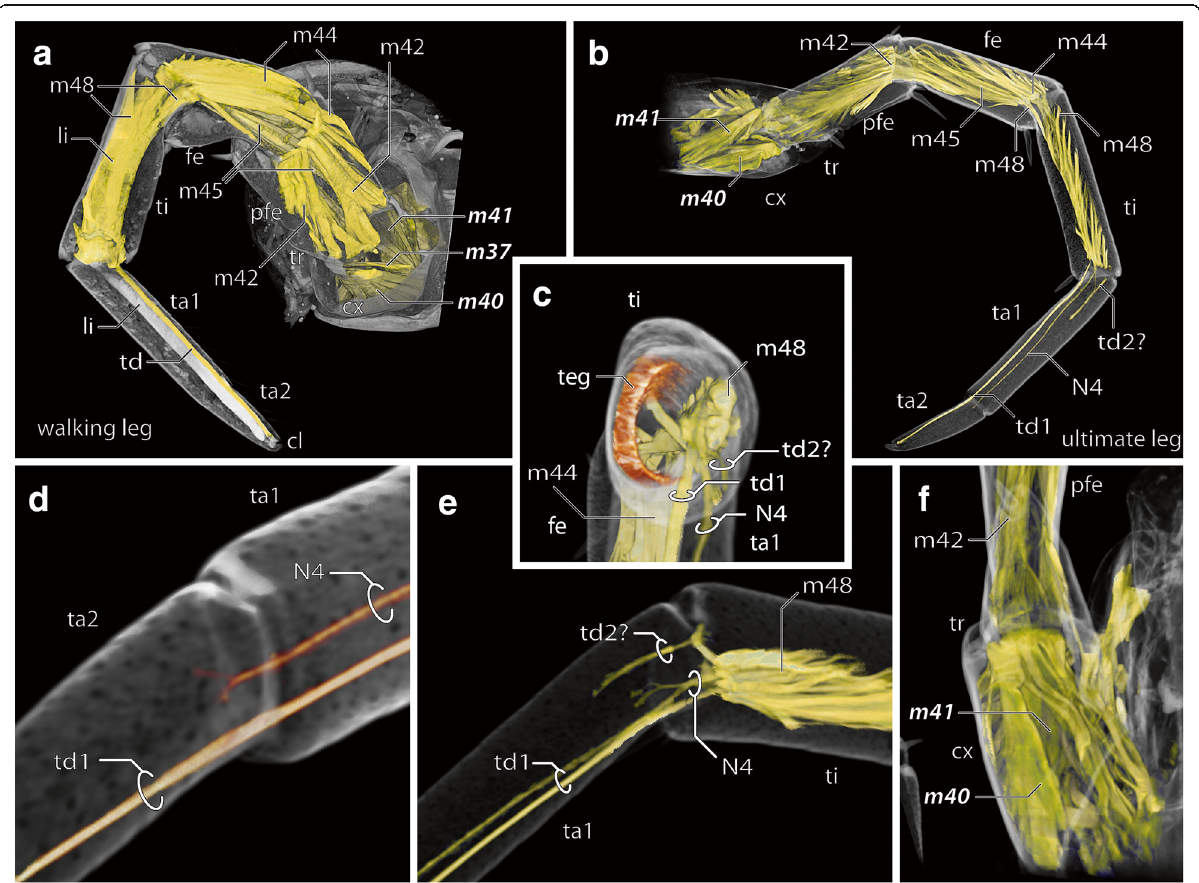
Fig. 4 Anatomy of walking leg 10 and ultimate leg. a 3D volume rendering of walking leg 10 and musculature, microCT analysis. Note that muscles labeled in bold either exhibit differences to ultimate leg muscles (m40 and m41, compare b ) or are absent in the ultimate leg (m37). b 3D volume rendering of ultimate leg and musculature, microCT analysis. Note that muscles labeled in bold exhibit differences to walking leg 10 (compare a ). c Detail of ultimate leg tibia showing ventrolaterad displacement of the claw tendon (td1), nerve N4, and muscle m48 by the tissue of the telopodal glands (teg). d Ultimate leg articulation of tarsus 1 and 2 with N4 branching in the proximal part of tarsus 2. Pores of telopodal glands are detectable in this visualization. e Tibio-tarsal articulation of the ultimate leg showing the branching of N4 in the proximal tarsus 1. Tarsus 1 houses a presumptive second tendon (td2?) supplied by a single muscle head from m48. f Right ultimate leg coxa from ventral. Note that the levator and depressor muscles m40 and m41 are substantially enlarged (compare a ). Abbreviations: cl claw, cx coxa, fe femur, li connective tissue ligament, m muscle. N nerve, pfe prefemur, ta tarsus, td1 claw tendon, td tendon, teg telopodal gland tissue, ti